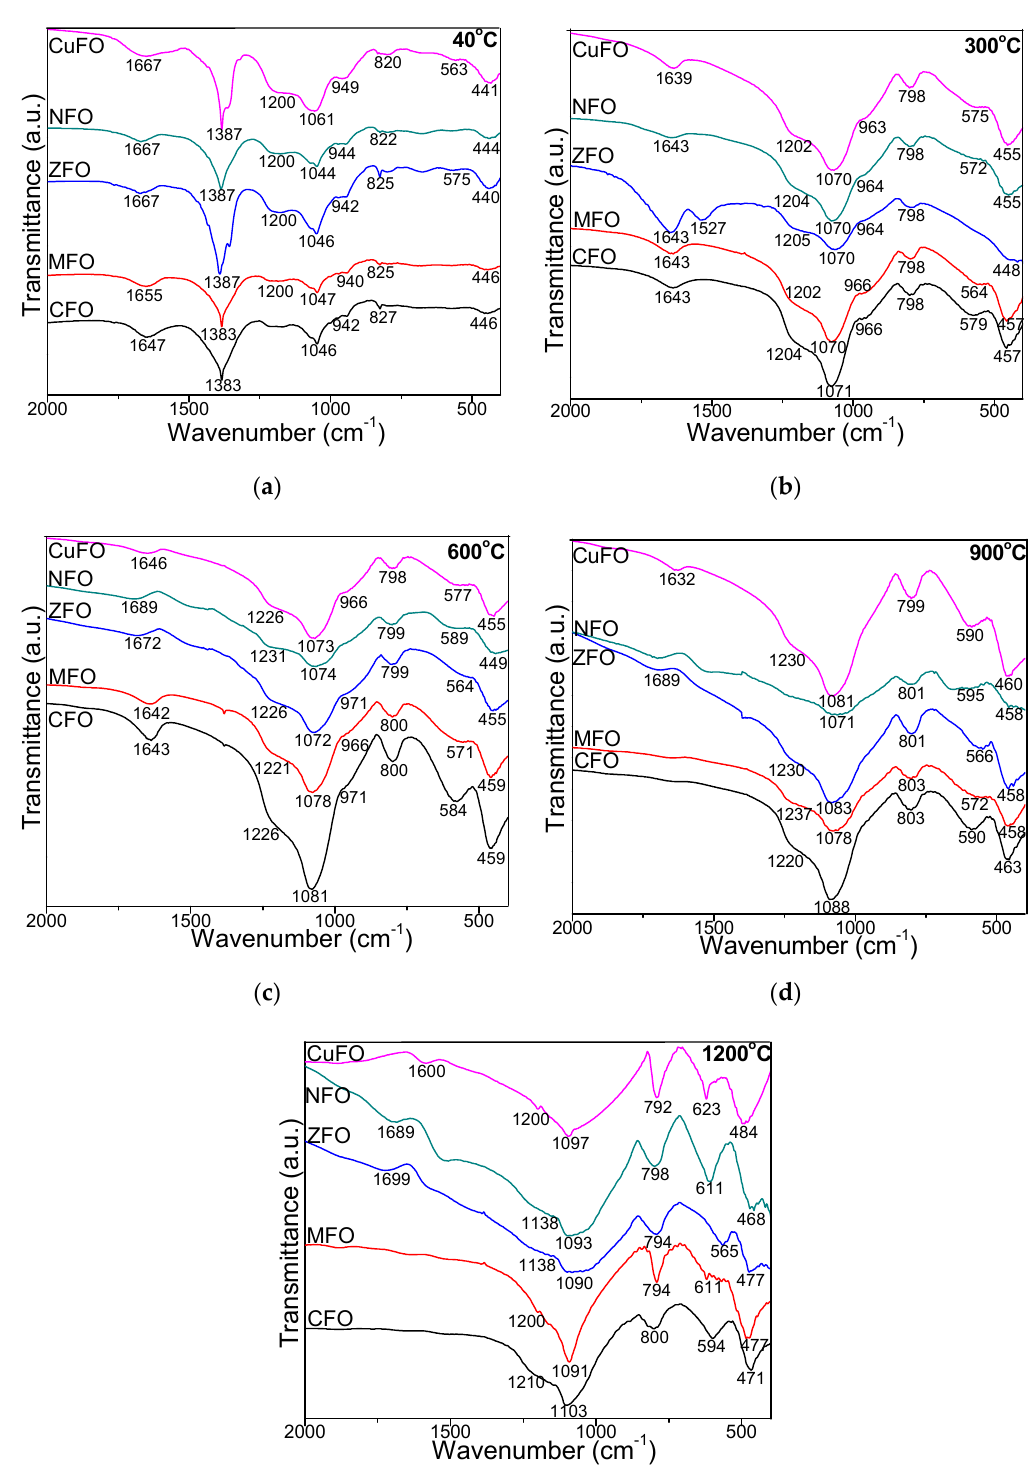
Figure 2. Fourier transform infrared ( FT-IR) spectra of CFO, MFO, ZFO, NFO, CuFO samples thermally treated at 40 °C ( a ), 300 °C ( b ), 600 °C ( c ), 900 °C ( d ), and 1200 °C ( e ).